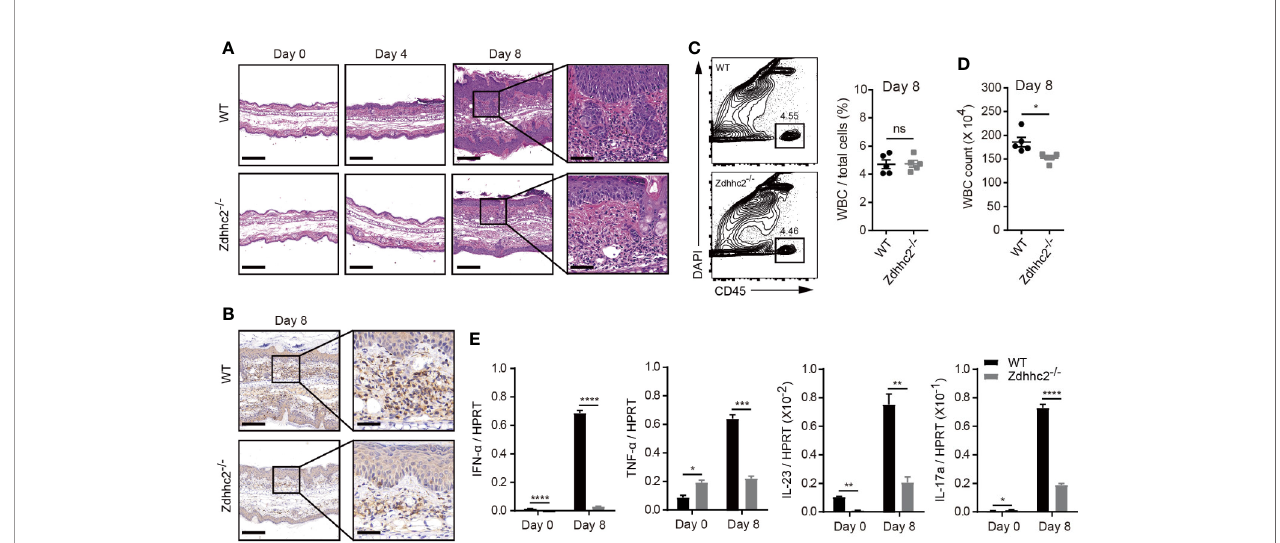
FIGURE 2 | Imiquimod-induced in fl ammation in Zdhhc2-de fi cient mice. (A) Representative H&E staining on histological sections of WT and Zdhhc2 de fi cient ears treated with imiquimod for 0, 4, and 8 days, respectively. (B) Representative IHC staining for CD45 on histological sections of WT and Zdhhc2 de fi cient ears treated with imiquimod for 8 days. Image captured at 50× magni fi cation, scale bars: 200 µm. Zoomed-in views of selected regions were captured at 200× magni fi cation, scale bars: 50 m m. Experiments were repeated twice, involving three mice for each time point per genotype. (C) The frequency of WBC was analyzed in psoriatic skin of WT and Zdhhc2 de fi cient mice after 8 days imiquimod treatment. The CD45 + single cells were gated with dead cell exclusion using DAPI a nucleic acid staining dye. (D) Absolute number of WBC were quanti fi ed by Attune NxT volumetric fl ow cytometer. Experiments were involving fi ve mice for each time point per genotype (mean ± SEM). (E) qRT-PCR was performed to analyze the expression level of four pro-in fl ammation cytokines in WT and Zdhhc2 de fi cient ears with (8 days) or without (0 days) imiquimod treatment (n = 3, mean ± SEM). * p < 0.05, ** p < 0.01, *** p < 0.001, **** p < 0.0001, unpaired Student ’ s t- test. ns, not signi fi